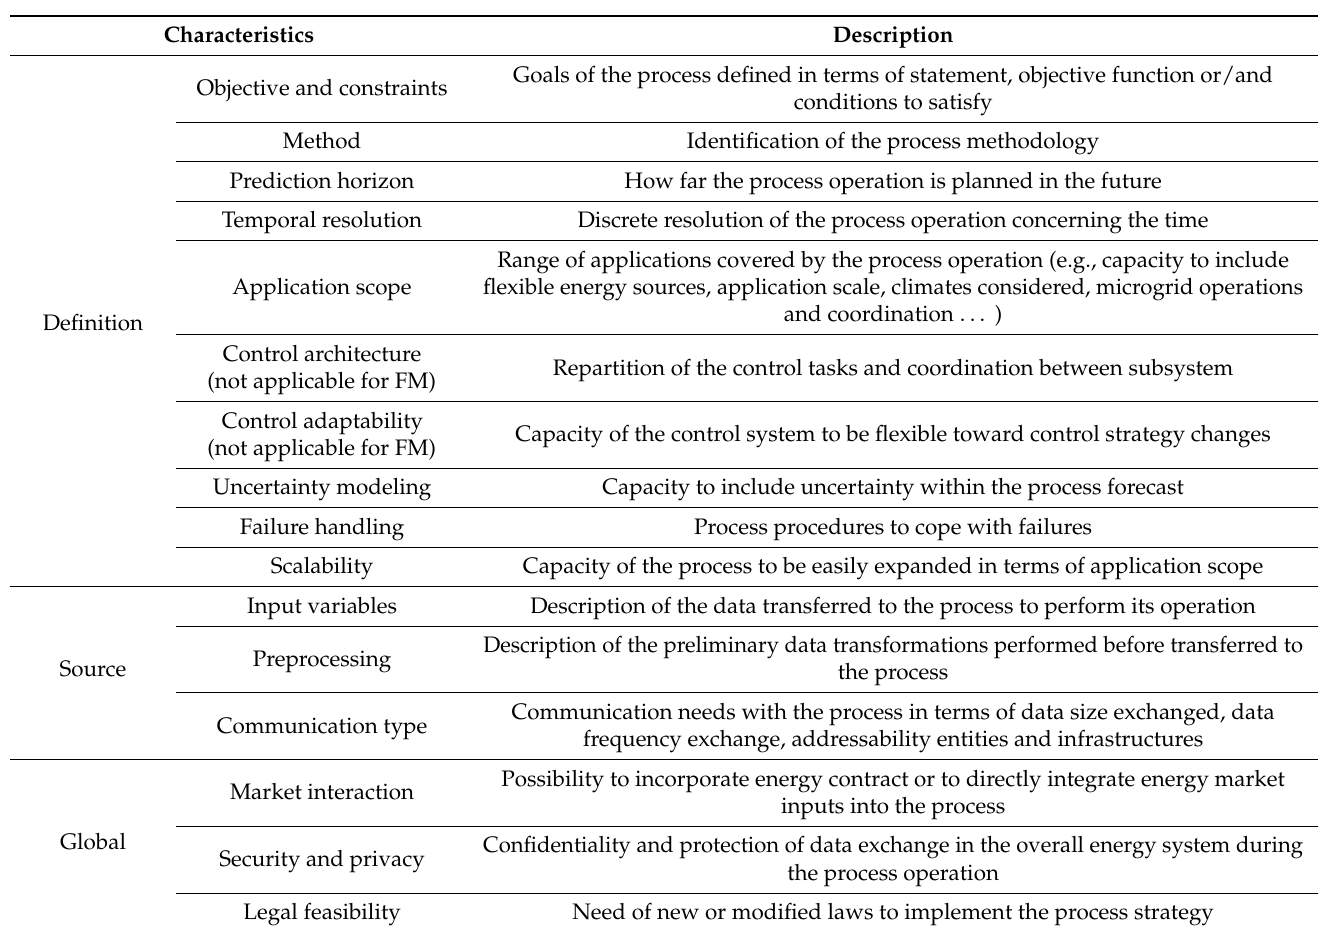
Table 8. Characteristics of energy management system (EMS)